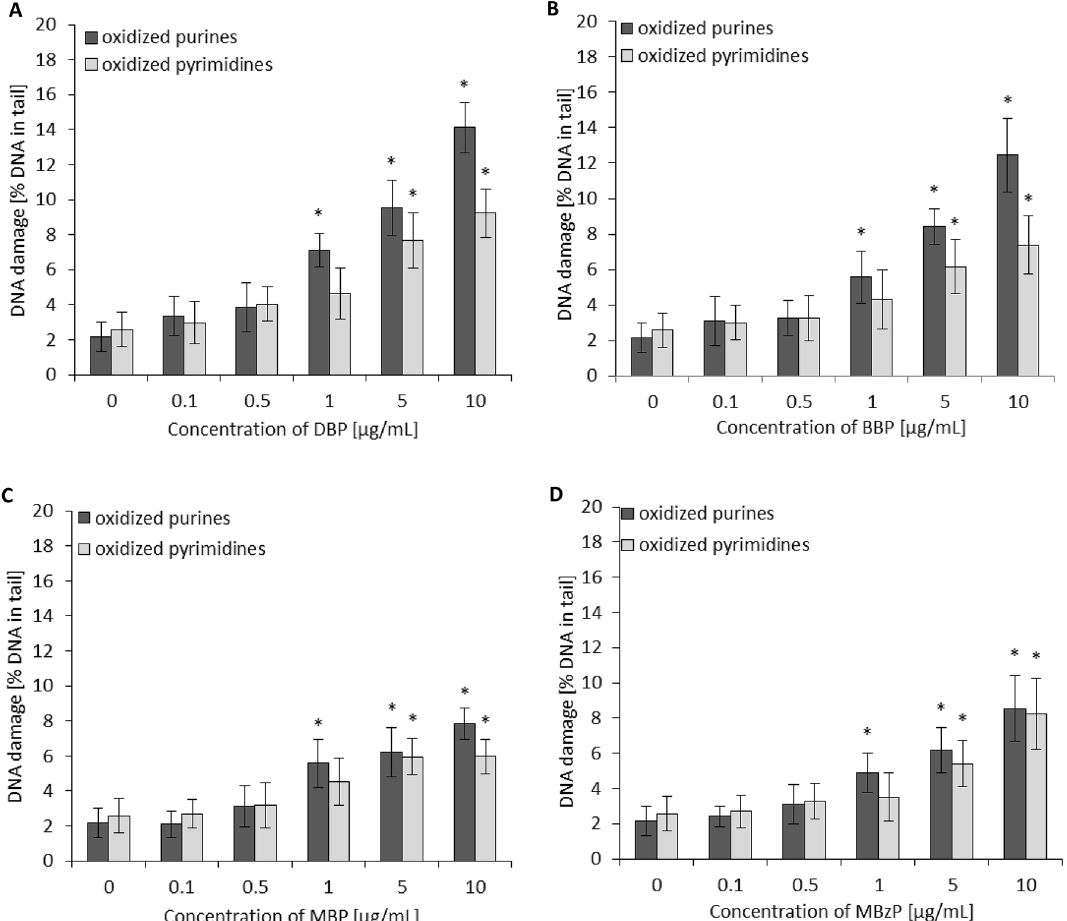
Figure 3. The level of DNA purines and pyrimidines oxidation in human PBMCs (analysis by means of alkaline version of the comet assay with human 8-oxoguanine DNA glycosylase—hOOG1 or endonuclease III–Nth). DNA damage in PBMCs was induced by DBP ( A ), BBP ( B ), MBP ( C ) and MBzP ( D ). The cells were incubated with phthalates in the concentrations range from 0.1 to 10 µg/mL for 24 h. The value of comet tail (damaged DNA) in the presence of either enzyme for different concentrations of phthalates was reduced by the value obtained in comet assay without any enzyme (value for enzymatic buffer for the appropriate concentration of phthalates). (*) Statistically significant different from control (p < 0.05). Each value represents the mean ± SD calculated from 5 individual experiments (5 blood